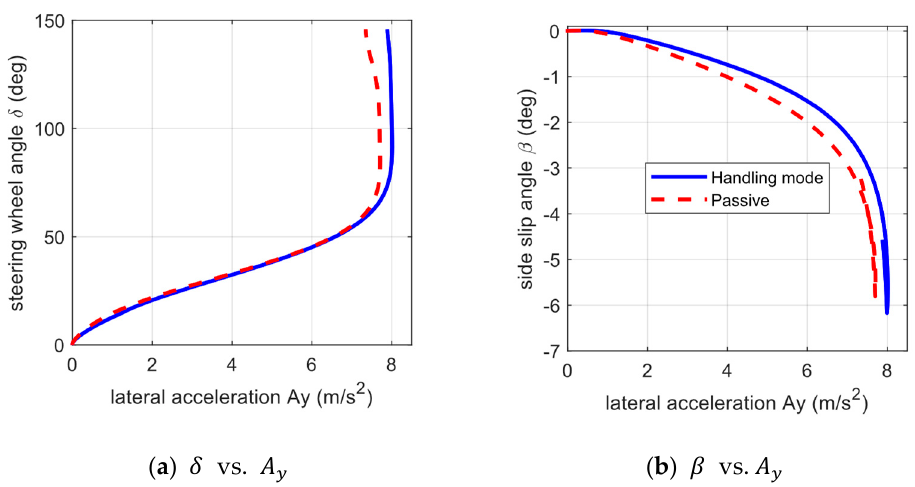
Figure 11. Results in the steering ramp test: ( a ) Lateral acceleration vs. steering wheel angle input; ( b ) Lateral acceleration vs. side slip